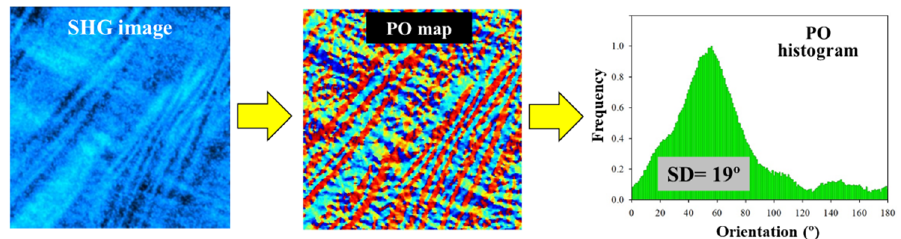
Figure 2. A schematic diagram that shows the use of the structure tensor. SHG images to be processed ( left panel ); spatially resolved map of POs ( central panel ); PO histogram showing the frequency of appearance of a certain orientation of the fibers within the SHG image ( right panel ). The value of SD is also presented for clarity (this is defined as the standard deviation of the PO